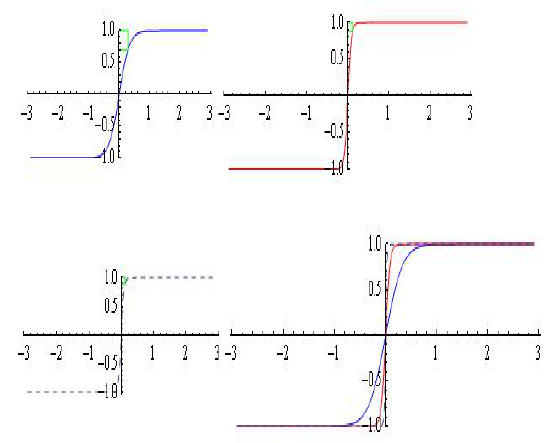
Fig. 6. The function A ( t ; β ) ; β = 4 , q = 0 . 01 , t 0 = 0 . 587335 ; Hausdorff distance d = 0 . 138899 ; β = 6 , q = 0 . 01 , t 0 = 0 . 701333 ; Hausdorff distance d = 0 . 111603 ; β = 8 , q = 0 . 01 , t 0 = 0 . 766378 ; Hausdorff distance d = 0 . 0992629 ; β = 10 , q = 0 . 01 , t 0 = 0 . 808266 ; Hausdorff distance d = 0 . 0867535 ; β = 16 , q = 0 . 01 , t 0 = 0 . 87543 ; Hausdorff distance d = 0 . 0632673 .